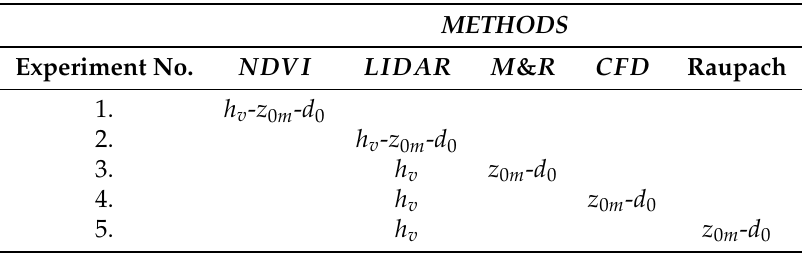
Table 1. Summary of methods used for the surface geometrical characterization in each experiment performed over the Yinke area.